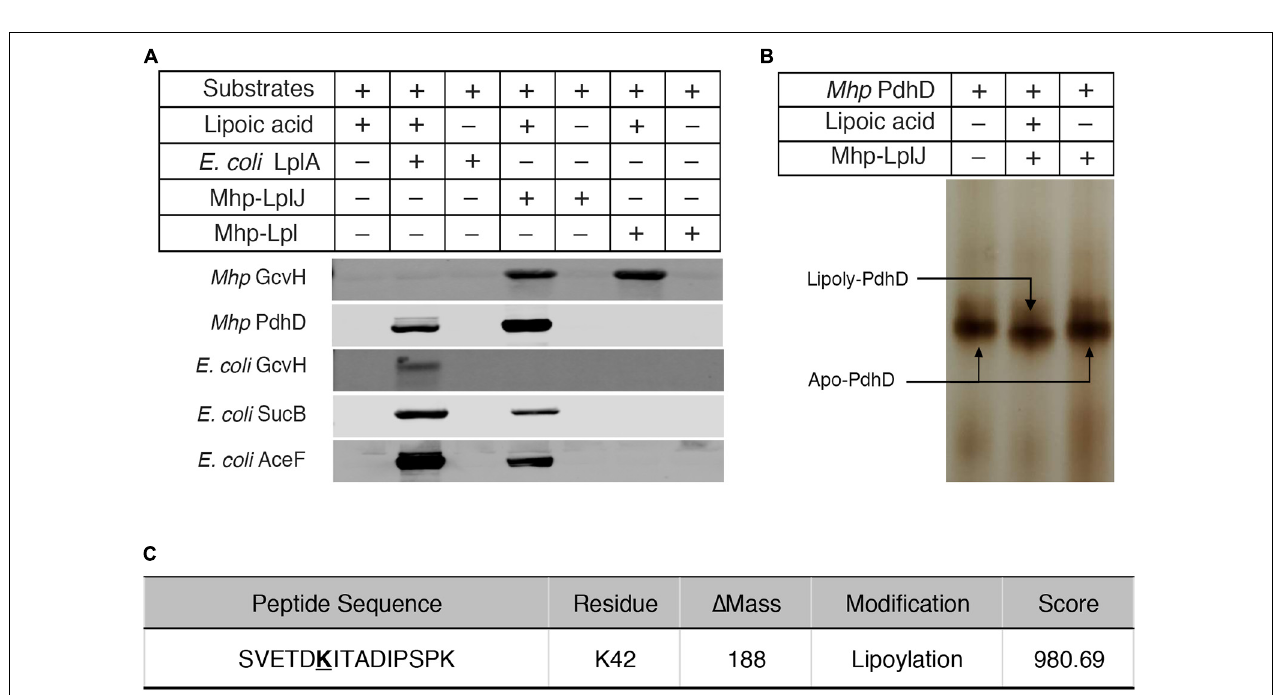
FIGURE 4 | Functional characterization of Mhp-LplJ in vitro . (A) The lipoate ligase activities of Mhp-LplJ and Mhp-Lpl were identified using lipoate ligase assays in vitro , with E. coli LplA as the positive control. Purified Mhp GcvH, Mhp PdhD, GcvH of E. coli ( E. coli GcvH), SucB of E. coli ( E. coli SucB), and AceF of E. coli ( E. coli AceF) were used as substrates. Lipoate modification of the substrate proteins was detected by western blot assays using Anti-LA. (B) Lipoate-modified PdhD catalyzed by Mhp-LplJ was analyzed using the gel shift assay. Loss of the positive charge at the lysine-binding site during lipoate modification resulted in faster migration on a native gel. (C) The lipoylation of PdhD was analyzed after chymotrypsin and trypsin digestion using LC-MS/MS assay. The lipoylated lysine residue of the peptide is in bold and underlined.